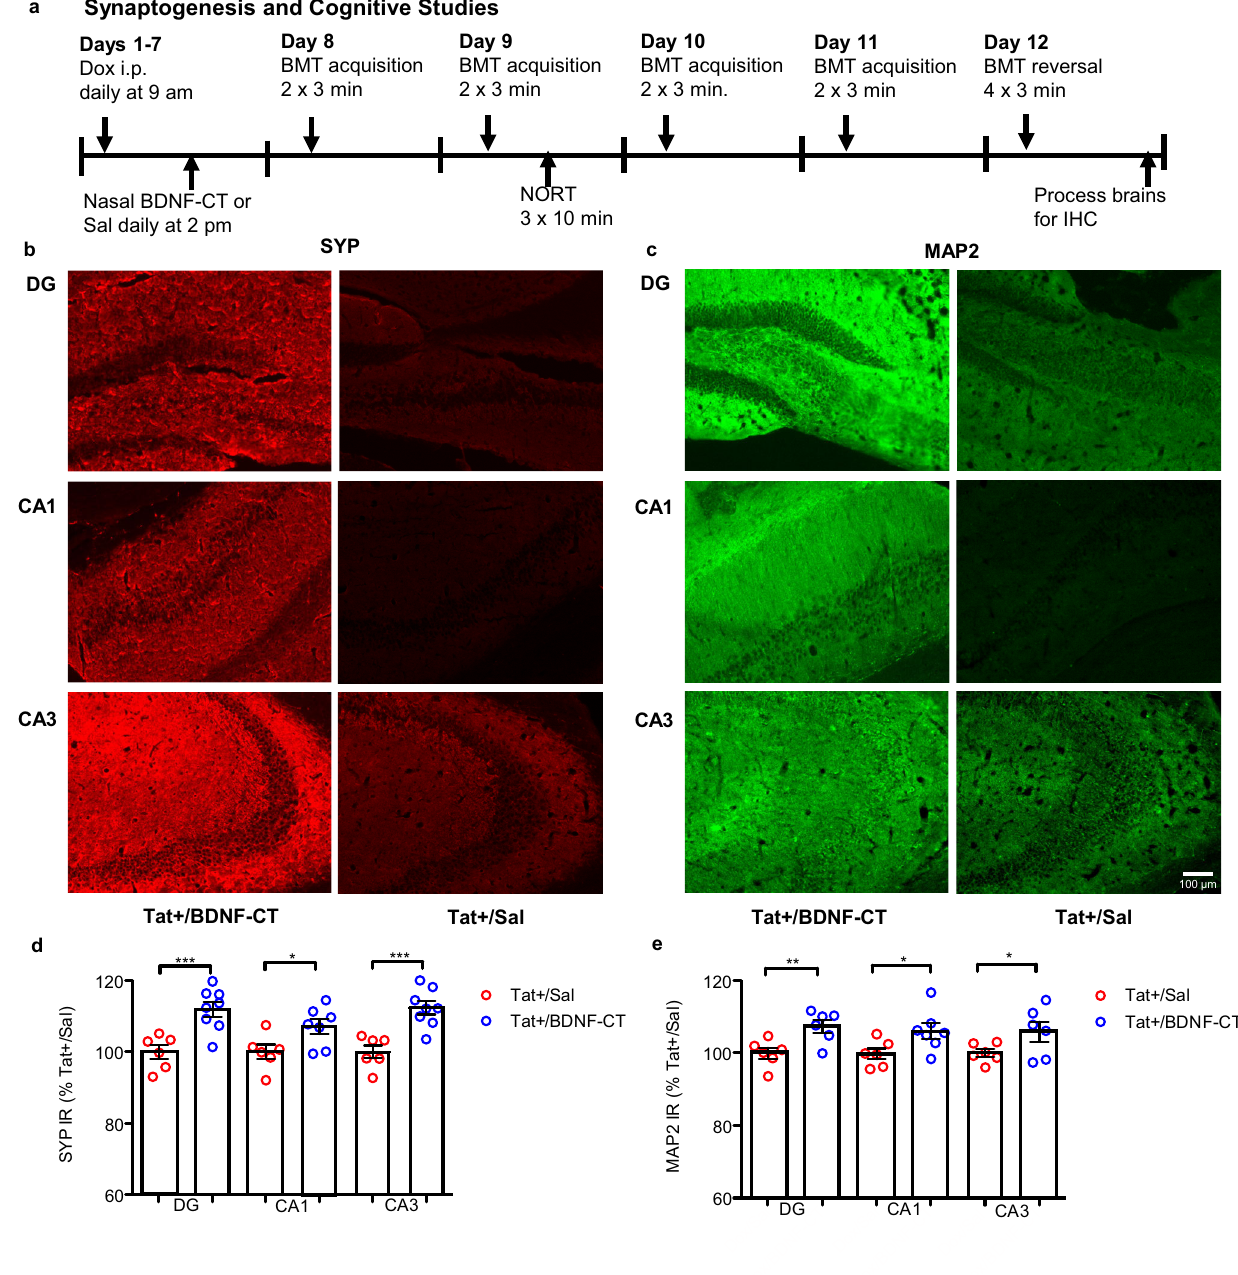
Fig. 6 BDNF-CT enhanced synaptogenesis and dendritic integrity in the Tat + mouse hippocampus. Tat + mice received i.p. Dox (100 mg/kg) and i.n. saline or BDNF-CT (0.23 mg/kg of BDNF and 1.85 mg/kg of CT) daily for 7 days. Cognitive testing started on the 8th day and lasted for 5 days ( a ). Mice were sacri fi ced on day 12 and hippocampal dentate gyrus (DG), CA1 and CA3 sections were evaluated for SYP + ( b ) (red) and MAP2 + ( c ) (green) staining. The SYP ( d ) and MAP2 ( e ) immunoreactivities (IR) increased in the hippocampal DG, CA1, and CA3 regions in BDNF-CT-treated Tat + mice vs. saline treated controls. Data are shown as the mean % change from saline treated controls. Error bars represent S.E.M. ( n = 6 – 8 per group; * P < 0.05, ** P < 0.01, *** P = 0.001). Scale bars are 100 µ